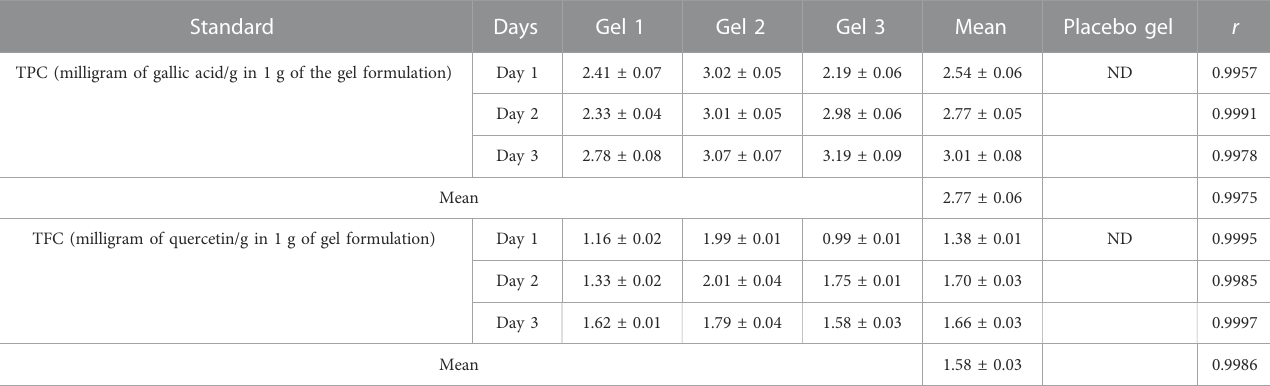
TABLE 3 Quanti fi cation of TPC and TFC in the gel formulation containing the B. pinnatum leaf extract at 5%. Standard Days Gel 1 Gel 2 Gel 3 Mean Placebo gel r TPC (milligram of gallic acid/g in 1 g of the gel formulation)